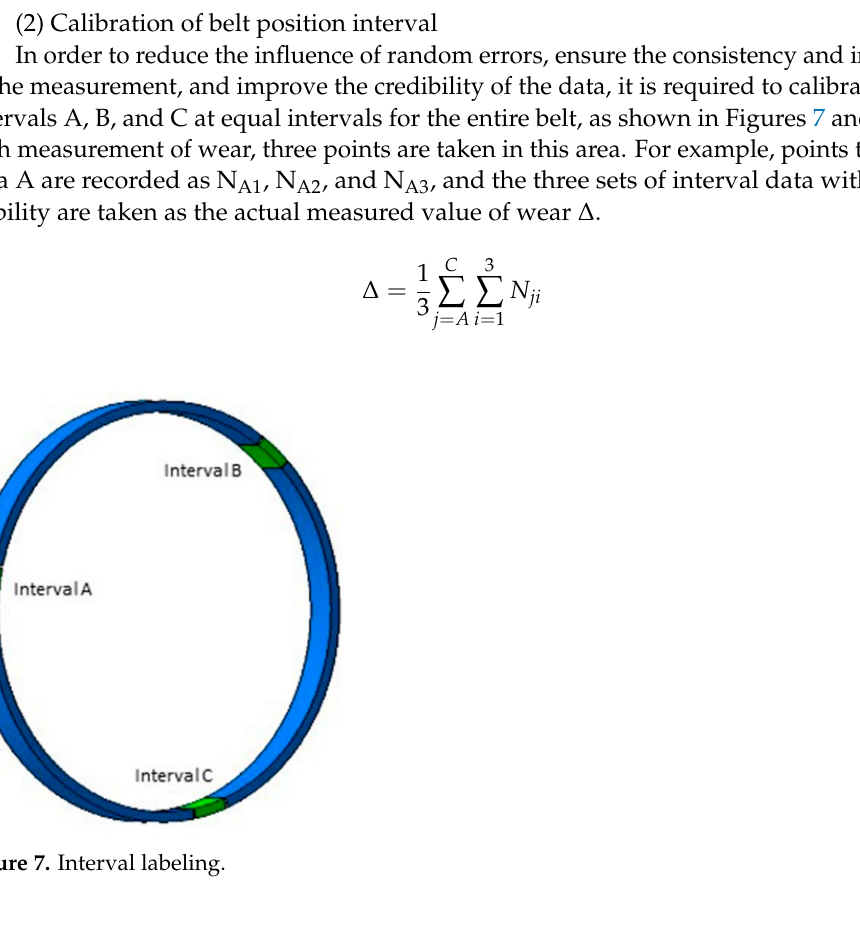
Figure 6. End of the severe wear stage.